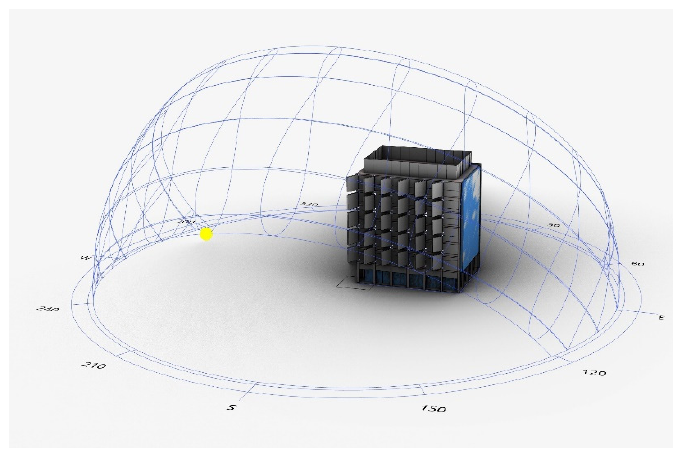
Figure 9. Application of the Sun path Algorithm to the Model.